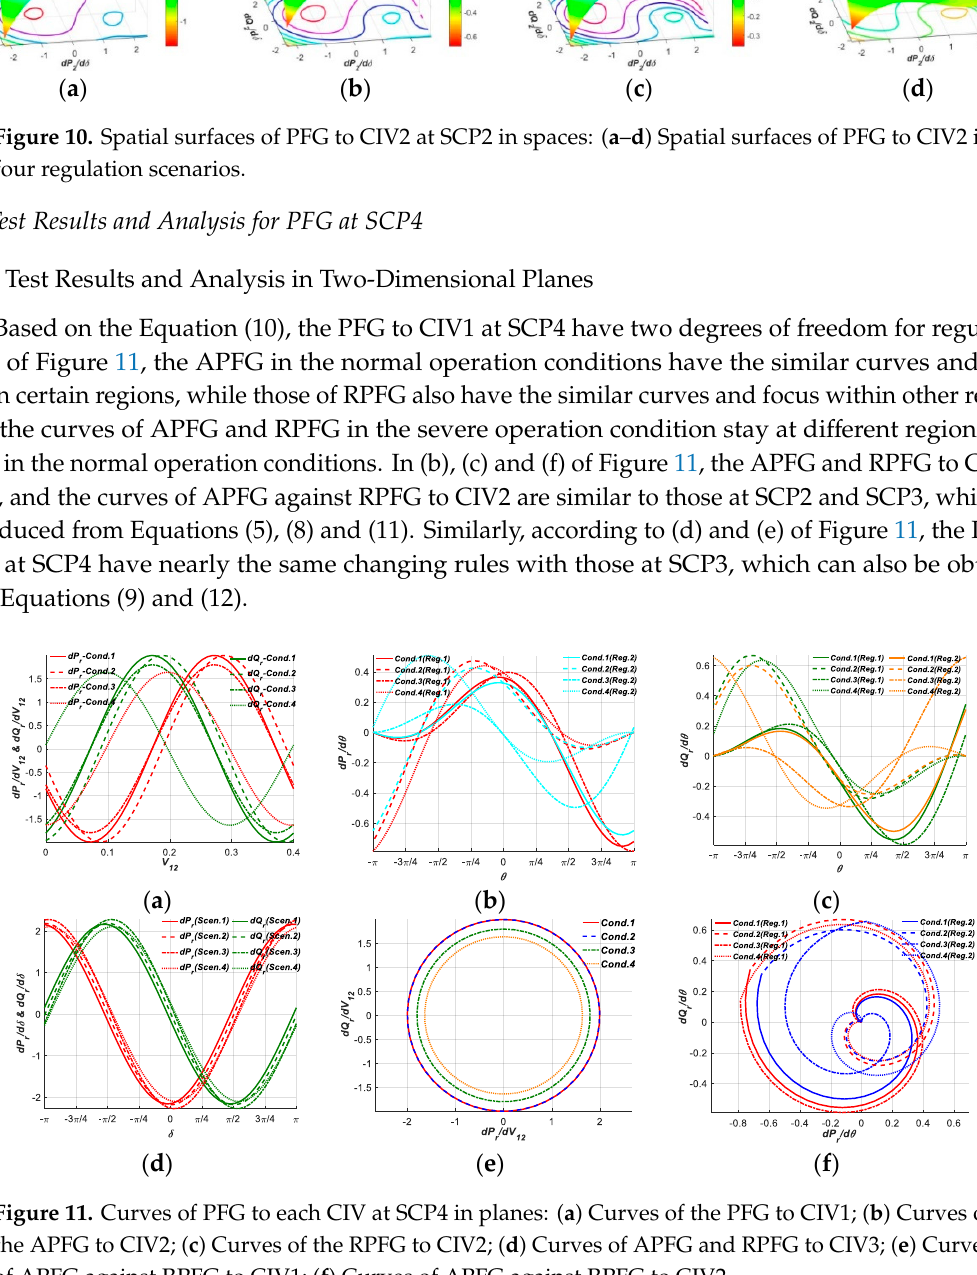
Figure 9. Spatial surfaces of PFG to CIV2 at SCP3 in spaces: ( a – d ) Spatial surfaces of PFG to CIV2 by Reg.1 of OSIV in four operation conditions; ( e – h ) Spatial surfaces of PFG to CIV2 by Reg.2 of OSIV in four operation conditions.